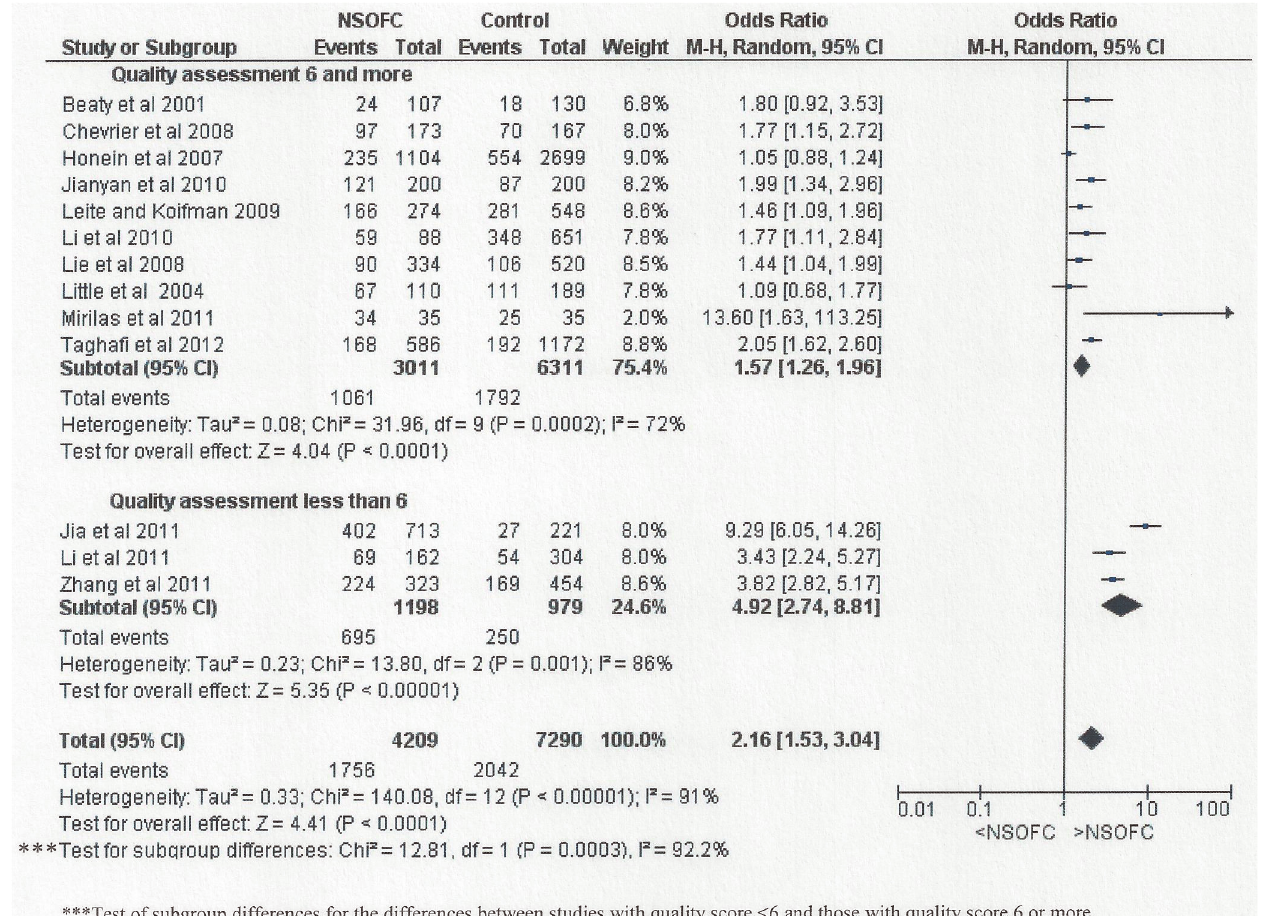
Fig 7. Forest plot for meta-analysis of the association between maternal passive smoking and NSOFC according to